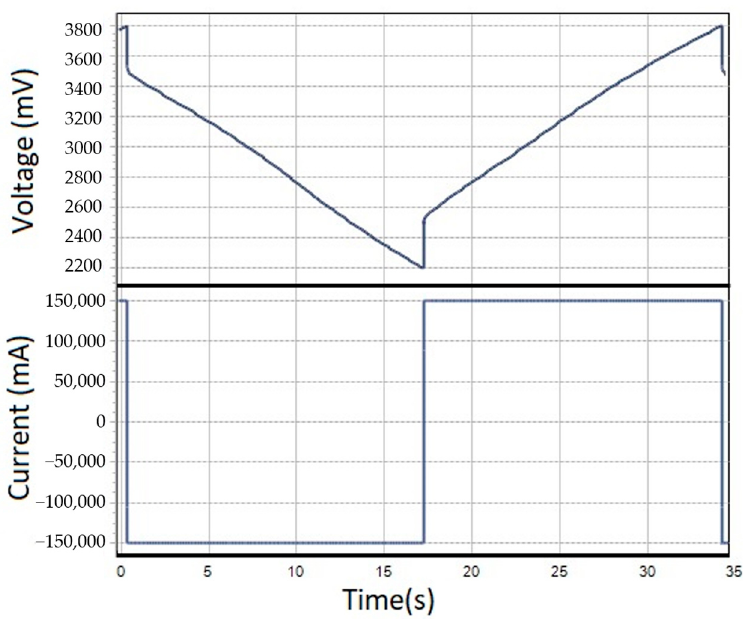
Figure 3. One period of the 150 A charge/discharge load profile to be used in the capacity degradation test.